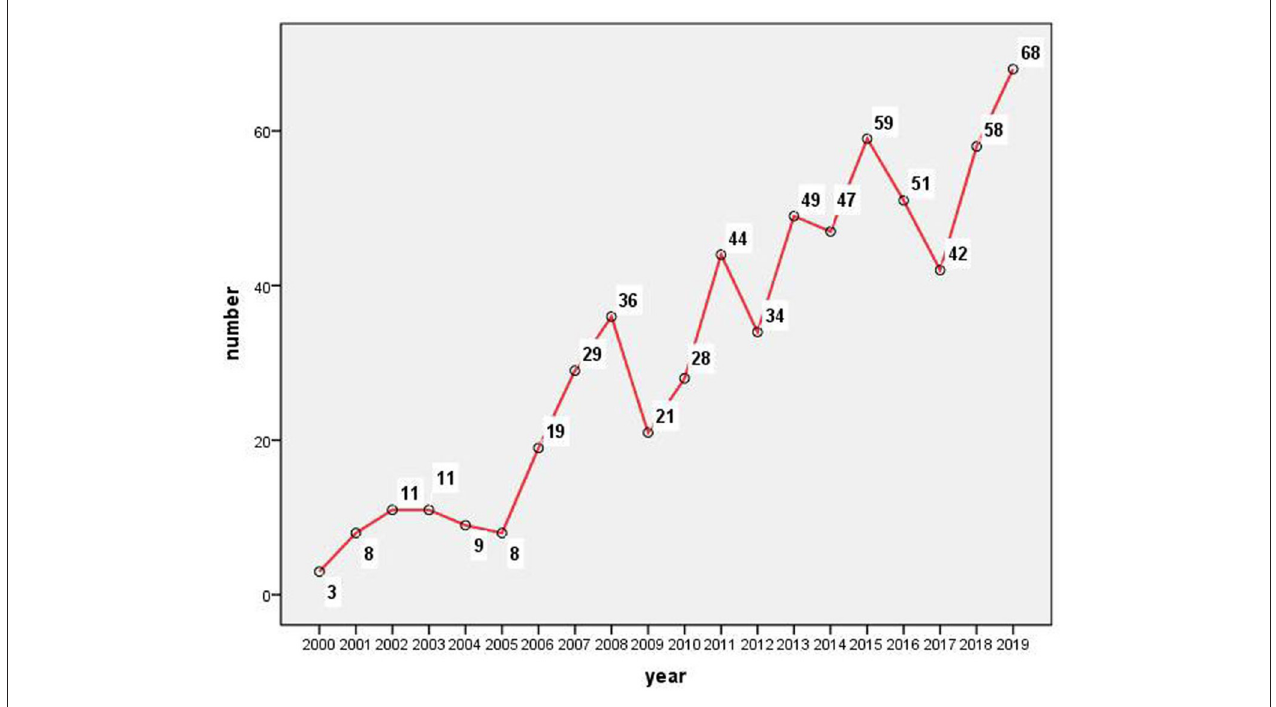
FIGURE 1 | The number of children with DCD publications indexed by WoSCC, 2000–2019.